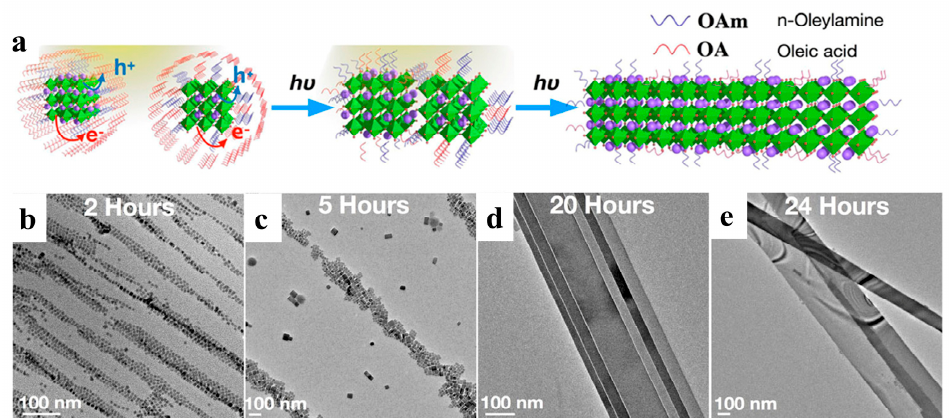
Figure 6. ( a ) Schematic illustration of the light ‐ induced selfassembly growth process. ( b – e ) Shape evolution of 1D CsPbBr 3 NWs with different illumination times under a light intensity of 1.7 suns: ( b ) NCs formed after 2 h, ( c ) nanorods formed after 5 h, ( d ) NWs formed after 20 h, and ( e ) NWs formed after 24 h. Reproduced with permission from reference [78]. Copyright 2019, American Chemical Society.